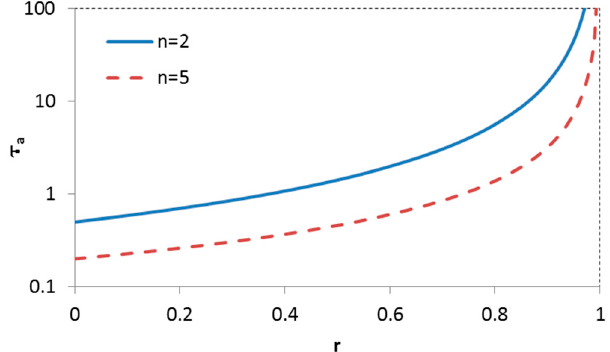
Figure 7. Morphological timescale as function of sea-level rise rate.